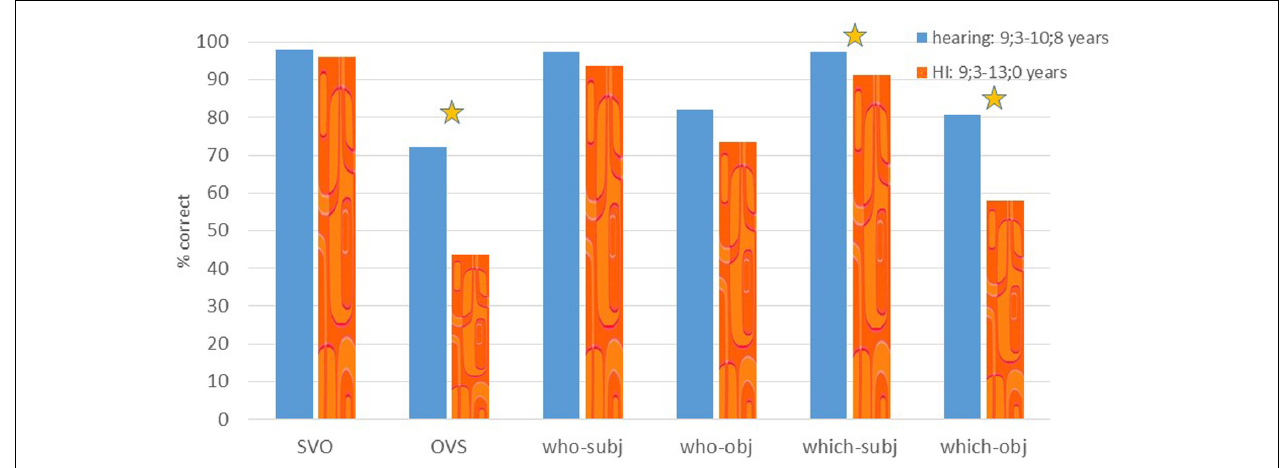
FIGURE 4 | % correct on Experiment 2: comprehension of SVO, topicalization, subject and object who and which questions. A star indicates a significant difference between the